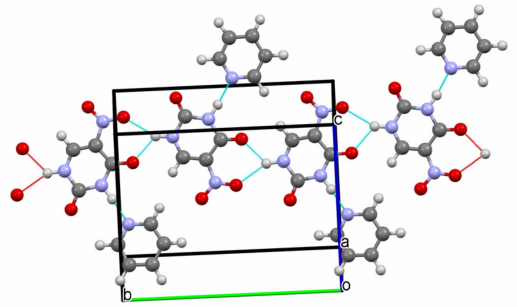
Figure 10. Hydrogen bonded chains in (IX) . In the hemikis(dioxane) solvate (X) of 5NU (Figure 11), the nitrouracil molecules are joined in centrosymmetric dimers with the M3 motif. The dimers are further interconnected for the first level hydrogen-bonding are R 2 2 (8) and C (4). The dioxane solvent molecules are not strongly bonded occupying the center and corners of the unit cell (colored in dark blue in Figure